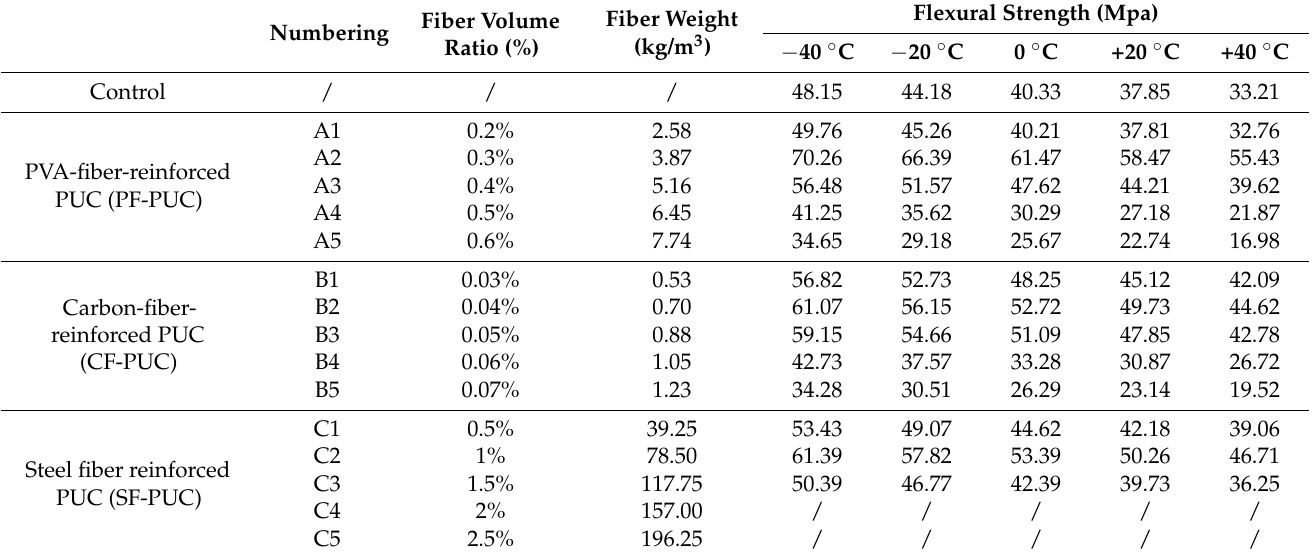
Table 3. The mix ratio of each group of test pieces.